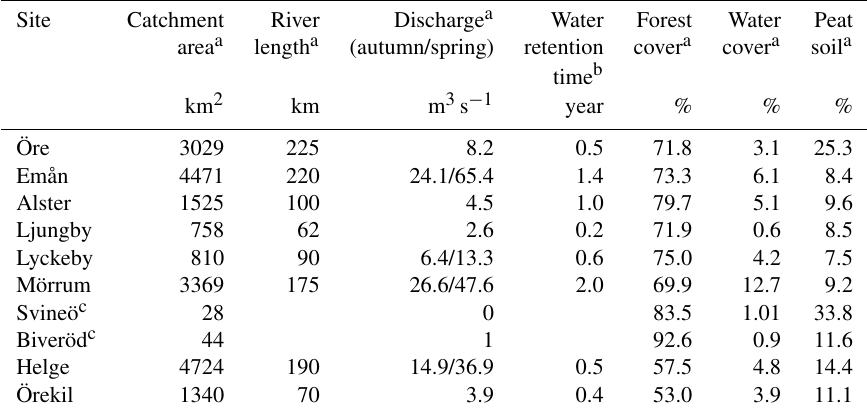
Table 1. Catchment characteristics.